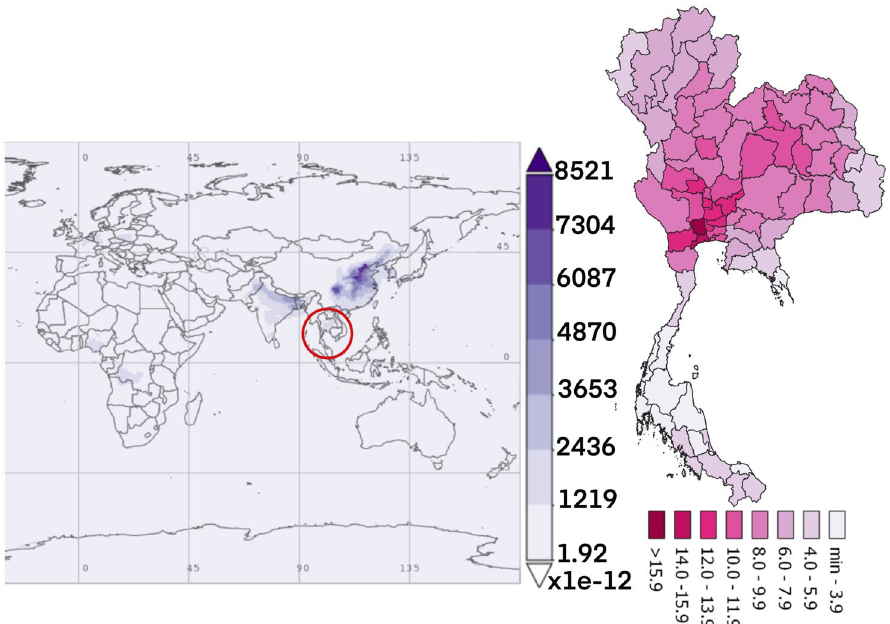
Figure 3. The average time of black carbon concentration monthly over 2010–2016. (The world map was generated by Giovanni Version 4.34: a free and open source earth data, https ://giova nni.gsfc.nasa.gov/giova nni/) and accumulated dose between 2010 and 2016 in Thailand (Thailand map was generated by QGIS software: a free and open source geographic information system, https